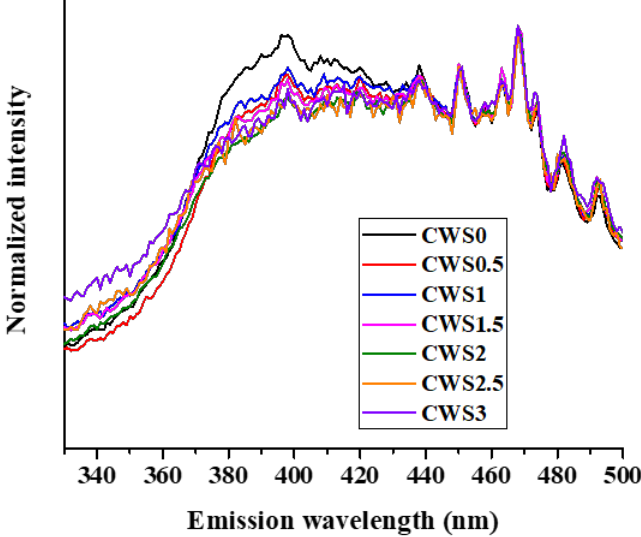
Figure 3. The PL spectra of the CWSX samples.